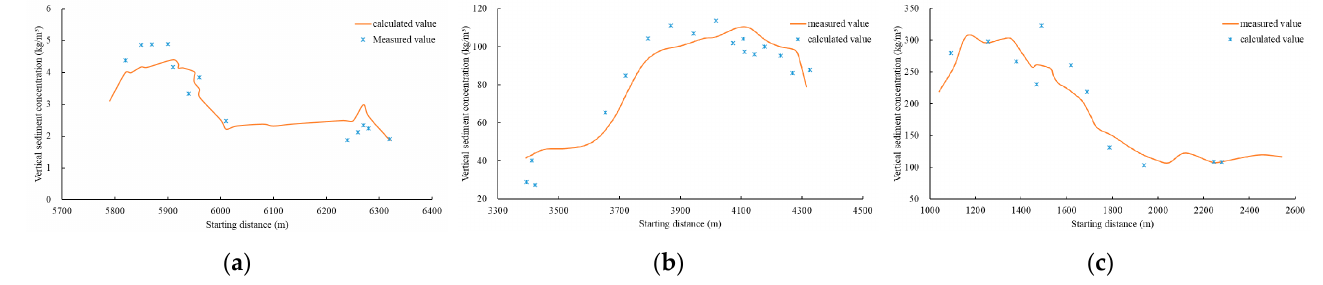
Figure 4. Verification of formula 9 by flood data with different sediment concentration: ( a ) low sediment concentration flood; ( b ) medium sediment concentration flood; and ( c ) high sediment concentration flood.